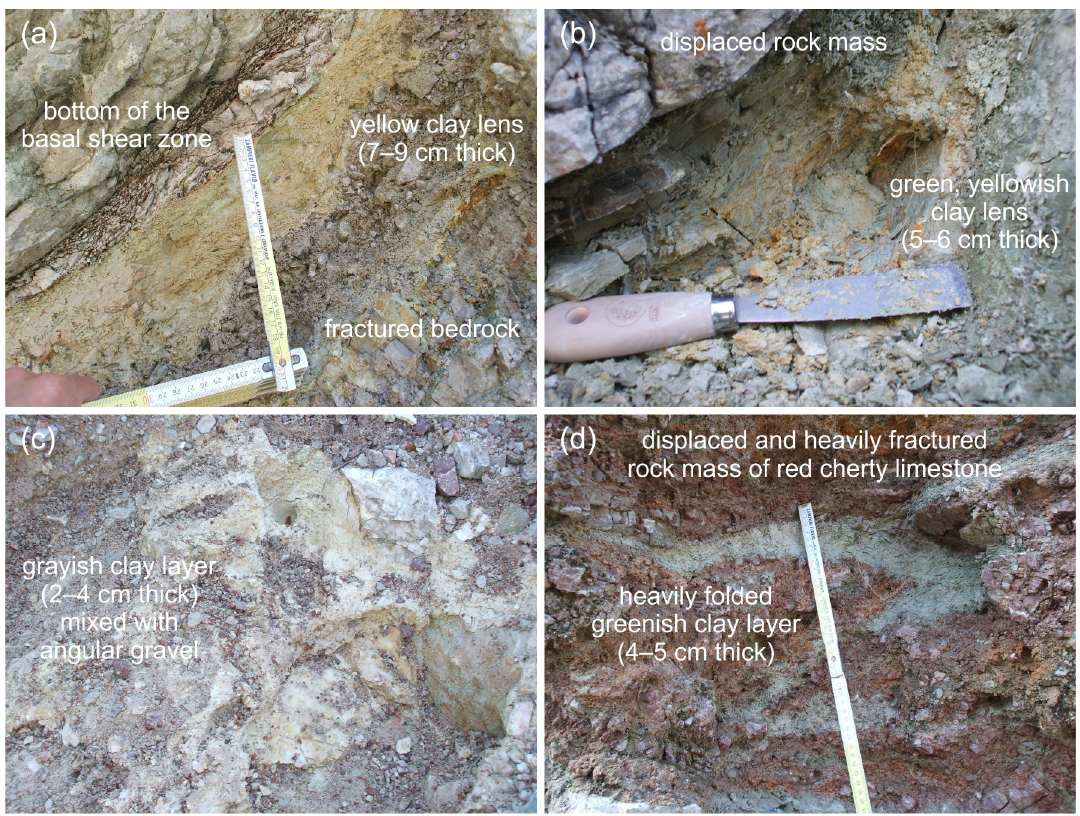
Figure 5. ( a ) Clay layers (cm thick) sampled from the detachment surface of the 1963 Vajont landslide. On the field, the clays mainly appear as yellow, ( b ) green, ( c ) or gray ( d ) lenses that can also be heavily folded.